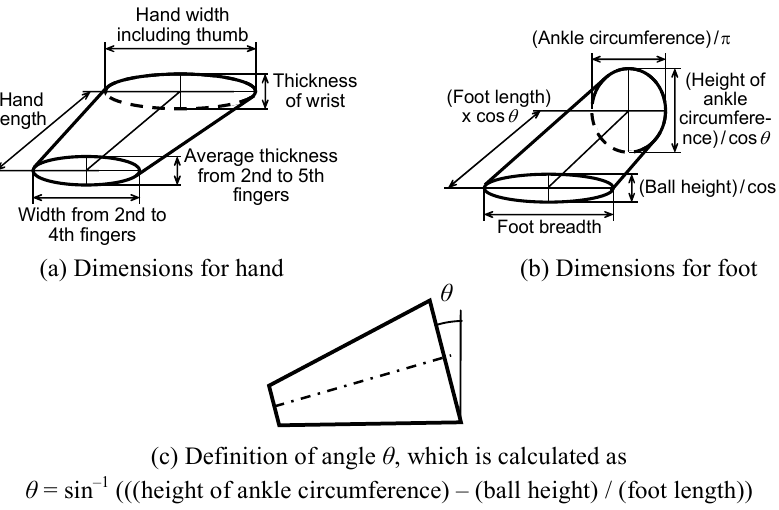
Fig. 7 Definitions of dimensions for hand and